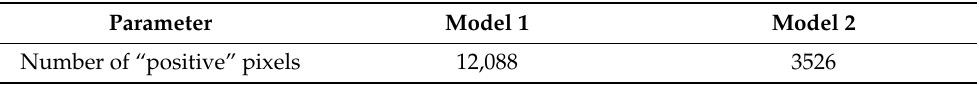
Table 4. Statistics of the identified “positive” pixels in Models 1 and